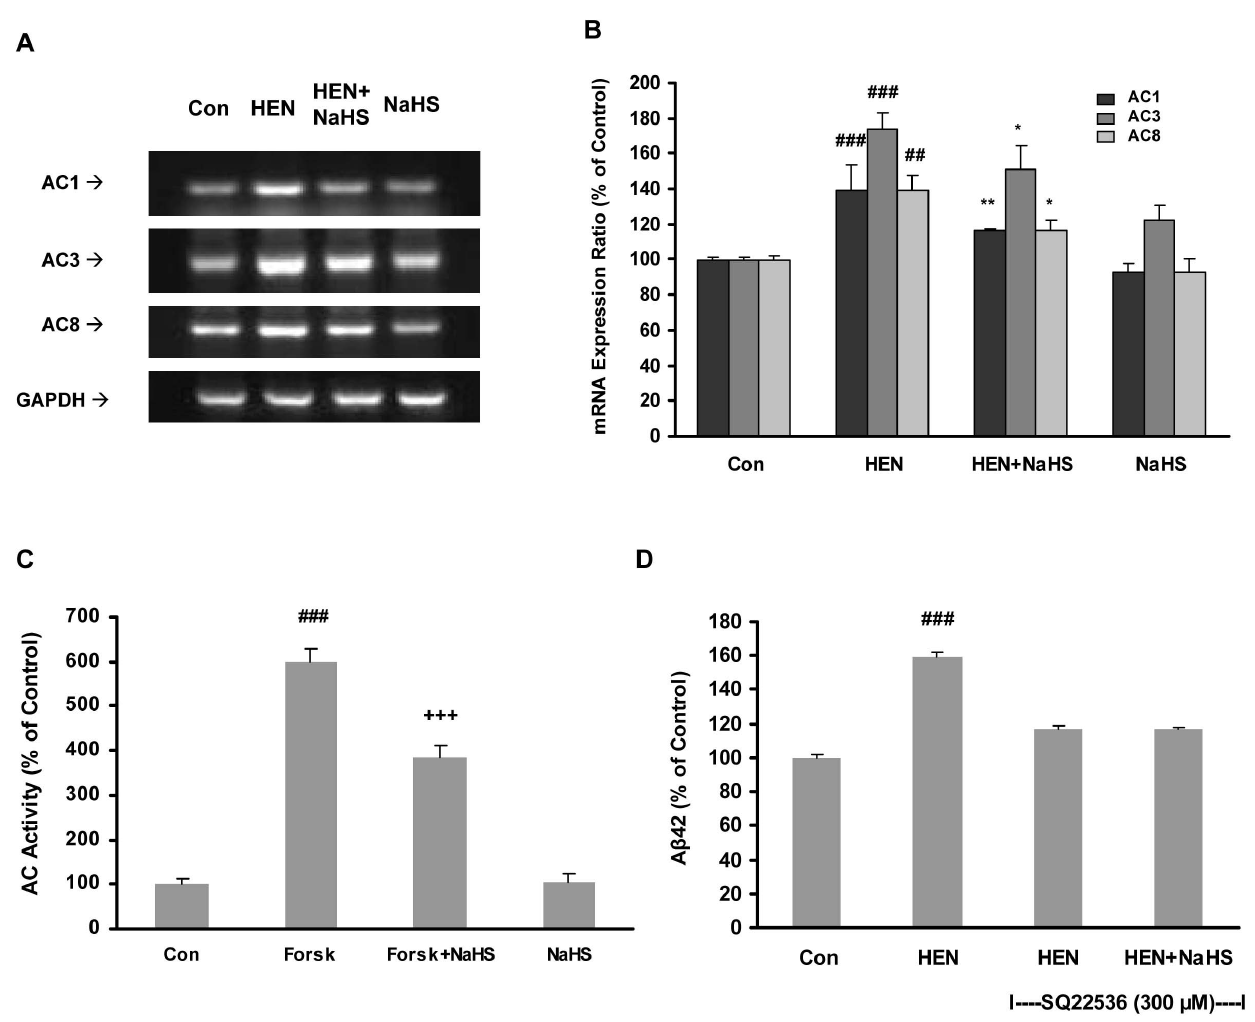
Figure 3. Effect of NaHS on mRNA expression of AC isoforms and AC activity. A–B : Representative gels (A) and histogram (B) demonstrating the effect of pretreatment with NaHS (100 m M, 12 hours) attenuated the effects of HENECA (100 nM, 24 hours) on mRNA expressions of AC isoforms. C : Effect of NaHS (100 m M) on AC activity stimulated by forskolin (20 m M). D : Effect of NaHS (100 m M) on A b 42 production in SH-SY5Y cells preincubated with AC antagonist, SQ 22536 (300 m M). Control values were adjusted to 100%. Data are given as means 6 S.E.M, n=4–6. ## p , 0.01, ### p , 0.001 vs Con group; +++ p , 0.001 vs Forsk group, * p , 0.05, ** p , 0.01 vs HEN group. Con, control; HEN, HENECA; Forsk, forskolin.